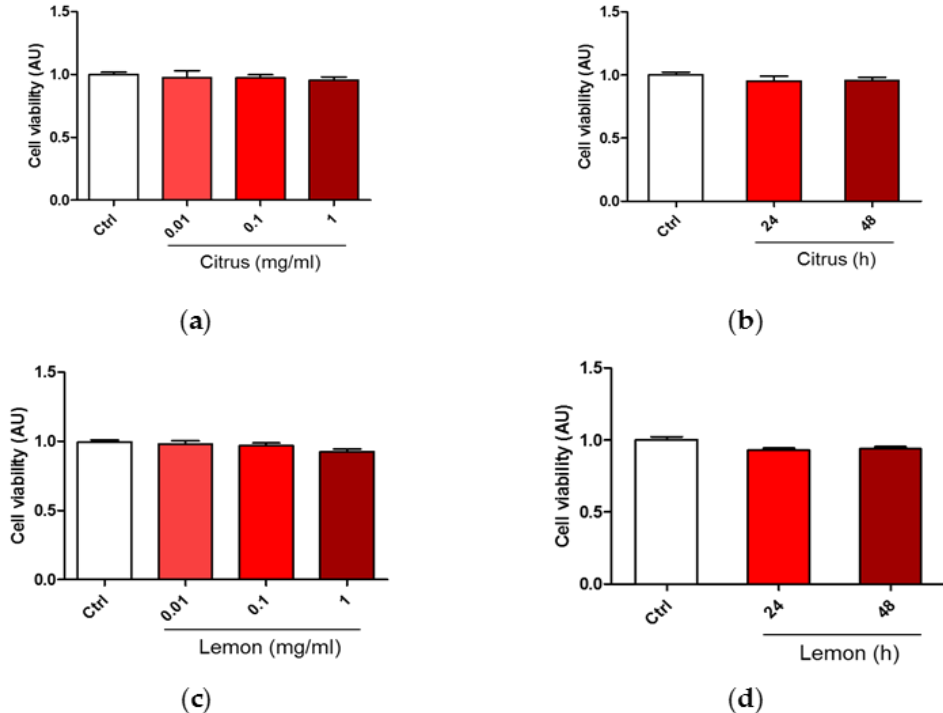
Figure 1. Dose and time dependent effects of commercial (citrus) and lemon IntegroPectin (lemon) pectins on neuronal cell viability: ( a ) Cell viability of citrus in dose dependent experiment; ( b ) Cell viability of citrus in time dependent experiment; ( c ) Cell viability of Lemon IntegroPectin in dose dependent experiment; ( d ) Cell viability of Lemon IntegroPectin in time dependent experiment.